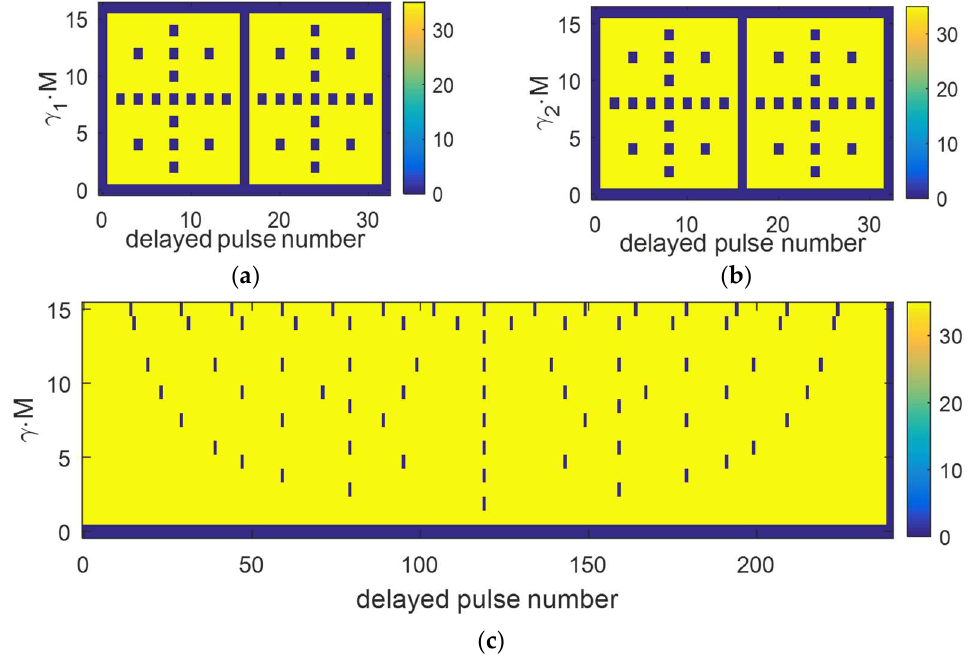
Figure 9. Suppression zones of false targets. ( a ) EPC-MIMO. ( b ) FDA-MIMO. ( c ) QPC-FDA-MIMO.